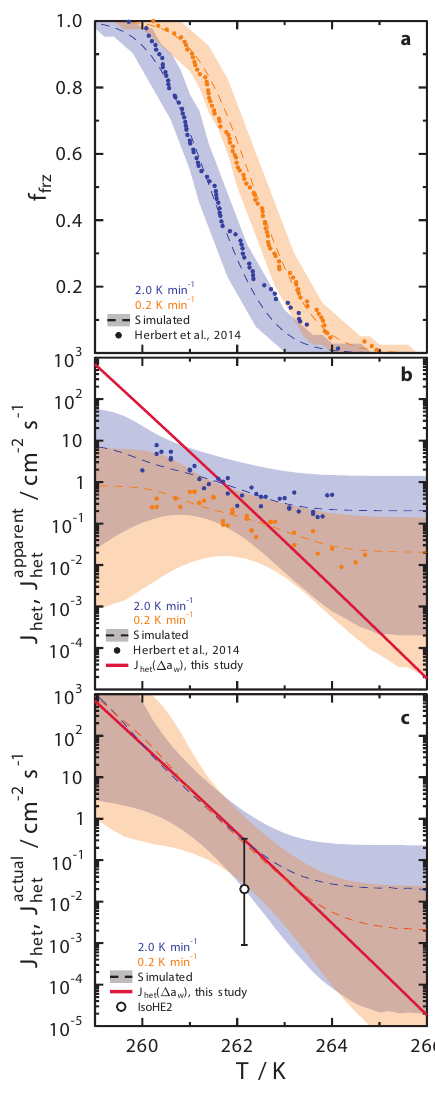
Figure 5. Frozen droplet fractions, f frz , and heterogeneous ice nu- cleation rate coefficients, J het , from immersion freezing cooling- rate, r , dependent model simulations CrHE1 and CrHE2, where r = 0 . 2 (orange) and 2 . 0Kmin − 1 (blue), and experimental data of feldspar acting as immersion INPs (Herbert et al., 2014). Dashed lines and shadings in (a) are f frz and 5th and 95th percentile bounds, respectively. J het as a function of temperature, T , are shown in (b) assuming uniform ice nucleating particle surface area (ISA) per droplet yielding J apparent and (c) accounting for variable het apparent ISA yielding J actual . The dashed lines in (b) and (c) are J het het actual and J het , respectively. Shadings in (b) and (c) correspond to up- per and lower fiducial limits with x = 0 . 999 confidence. Experi- mentally derived f frz and J het are shown as circles in (a) and (b) , respectively (Herbert et al., 2014). The red line in (b) and (c) is calculated from Eq. (6) (Knopf and Alpert, 2013) using new param- eters derived for feldspar. Parameter values for CrHE1 and CrHE2 are given in Table 2. The fitted J het value from model simulation IsoHE2 is shown in (c) and its corresponding error derived from Fig. 9 considering N tot = 40, σ g = 8 . 5 (see Table 1) and a tempera- ture error, (cid:49)T = ± 0 .